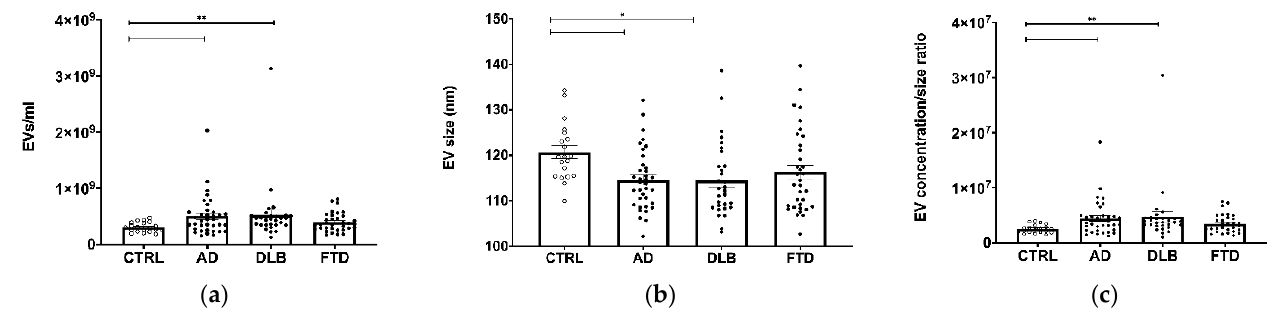
Figure 1. EV size and concentration are altered in AD and DLB CSF. ( a ) NTA analysis of EV concen- tration in CSF samples. A statistically significant increase in EV concentration was observed in AD and DLB groups compared to CTRL group. ( b ) EV size was significantly decreased in AD and DLB compared to CTRL group. ( c ) EV concentration/size ratio was increased in AD and DLB compared to CTRL group. Average ± SEM; * p < 0.05, ** p < 0.01. Bar plots represent raw data while the post-hoc p -values were obtained by generalized linear model adjusted for age.